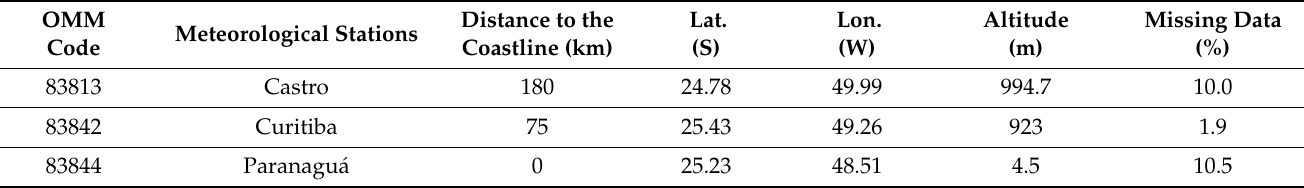
Table 1. Geographic location, altitude, and failures of the meteorological stations Castro, Curitiba, and Paranagu á